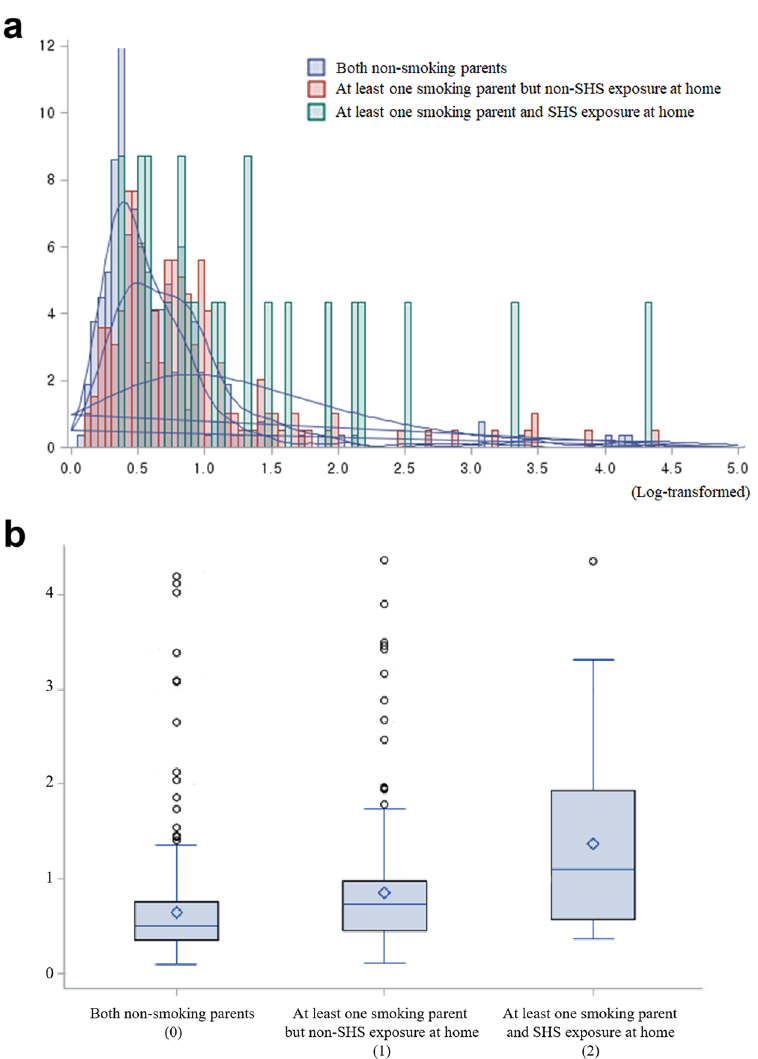
Figure 2. Children’s urinary NNAL level according to parental smoking patterns. ( a ) Children’s urinary NNAL((4-(methylnitrosamino)-1-(3-pyridyl)-1-butanol) distribution according to parental smoking patterns. ( b ) Tukey’s post-hoc test: 0 < 1 < 2 ( p value of 0.05). Age, sex, and secondhand smoke at public places were